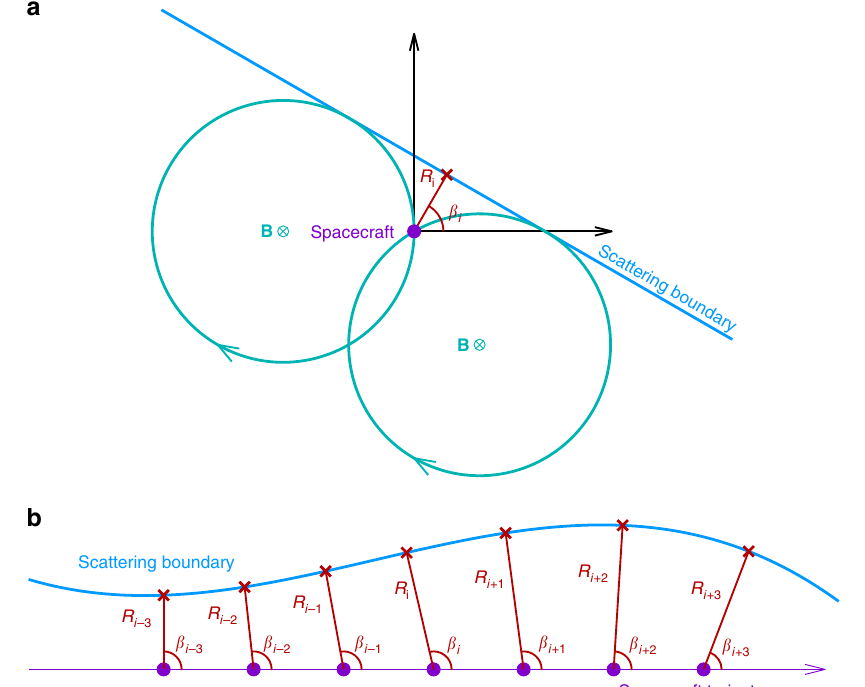
Fig. 7 Schematic diagram of the energetic particle sounding technique. In panel a a spacecraft (purple dot) is located near a scattering boundary. In the plane perpendicular to the magnetic fi eld, the particle detector needs to collect electrons from all directions to get a full perpendicular PSD (PSD ⊥ ). However, the measured PSD ⊥ is not gyrotropic because electrons outside the boundary can be scattered away by the boundary. Two critical looking directions ( ϕ 1 and ϕ 2 ), corresponding to the gyro-orbits tangential to the boundary (two cyan circles), can be recognized by sharp PSD declines. The two critical directions as well as the particle gyro-radius can be used to calculate the boundary orientation ( β i ) and distance ( R i ) to the spacecraft. Panel b shows an example of boundary sounding. Using PSD ⊥ data for a certain energy channel, the sounding technique generates a data point (red) at each moment, leading to a series of orientations ( β i − 3 , … , β i + 3 ) and distances ( R i − 3 , … , R i + 3 ) throughout the whole traversal. The corresponding data points (red crosses) are obtained based on the known spacecraft location. The boundary geometry can be obtained by connecting these points